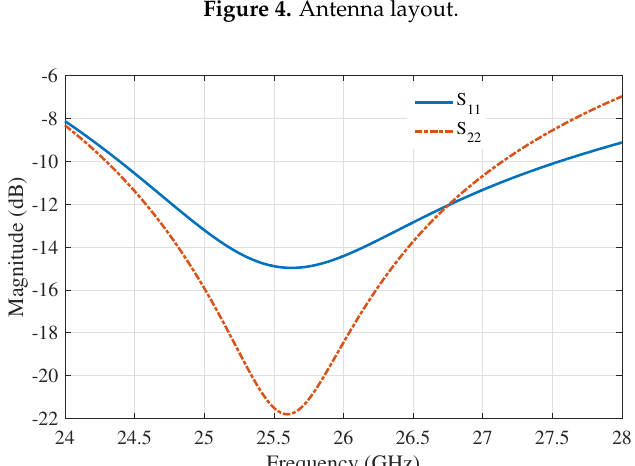
Figure 5. S 11 and S 22 magnitudes as a function of frequency for the patch antenna without matching